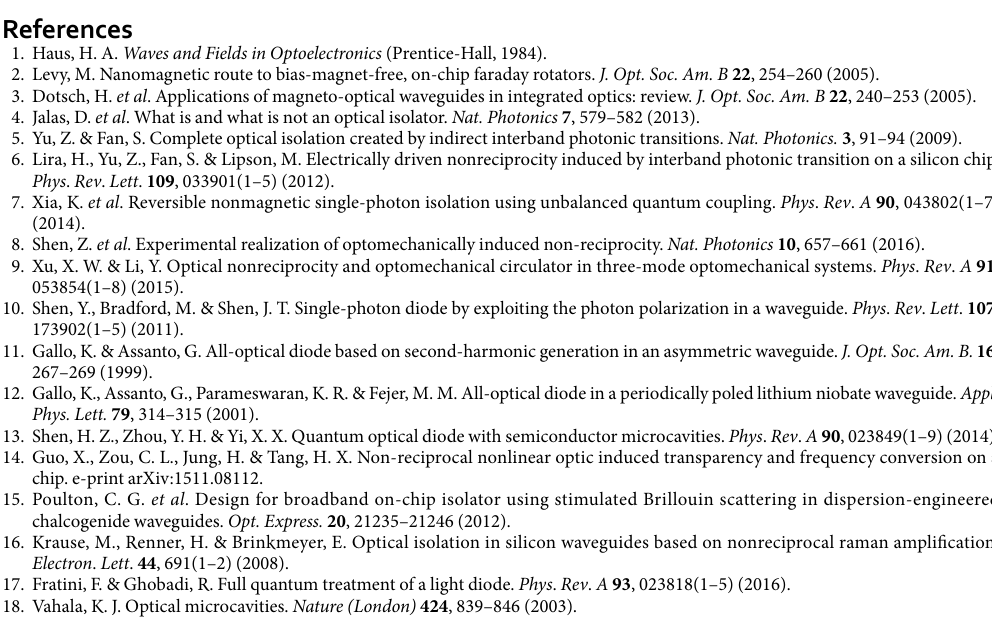
Figure 7. The output field controlled by the frequency detuning. The output field ( a , c ) a R function of the input field ε κ /